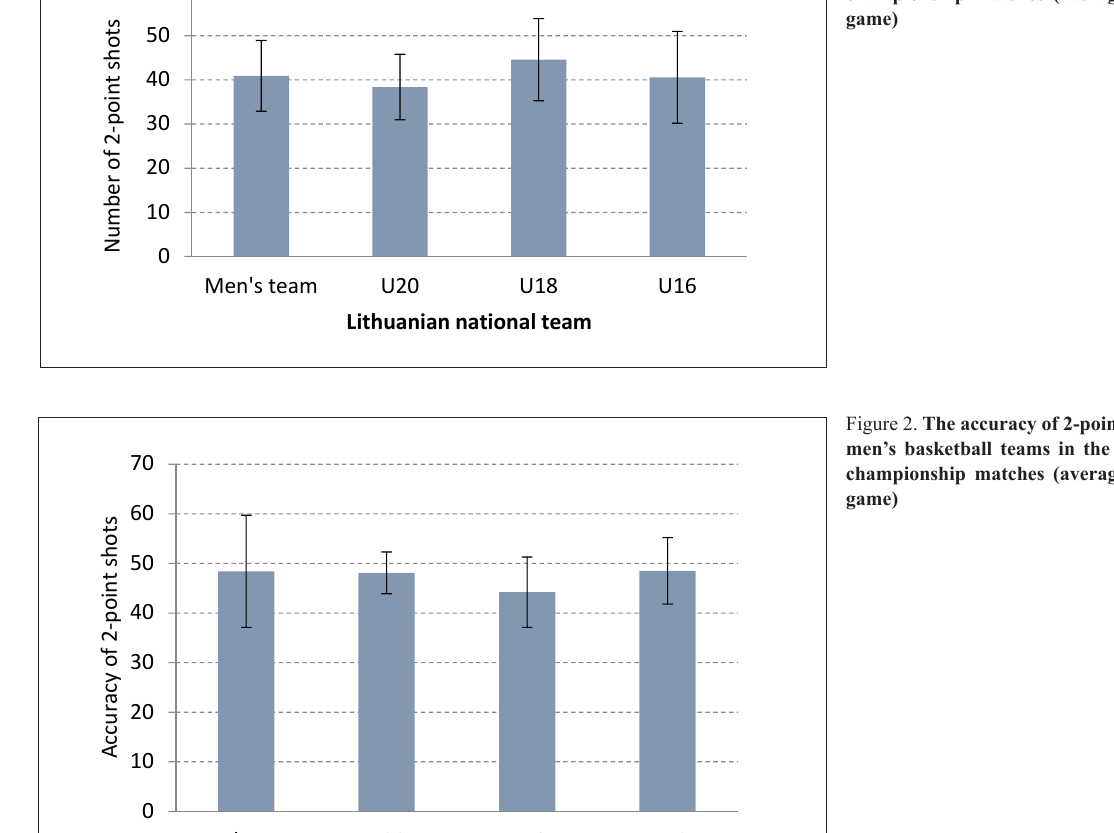
Figure 1. The number of 2-point shots for